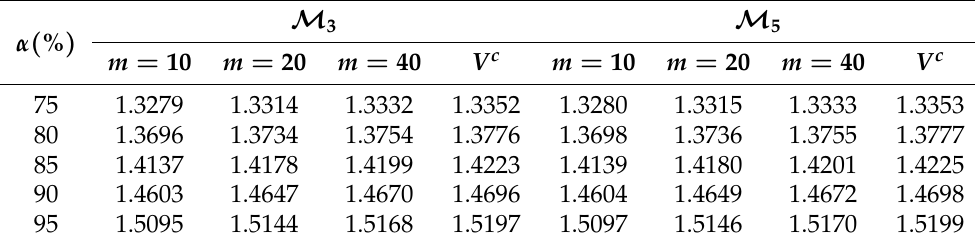
Table A2. Valuation results w.r.t. α , g = 2.50%, σ = 0.25, and n = 3.